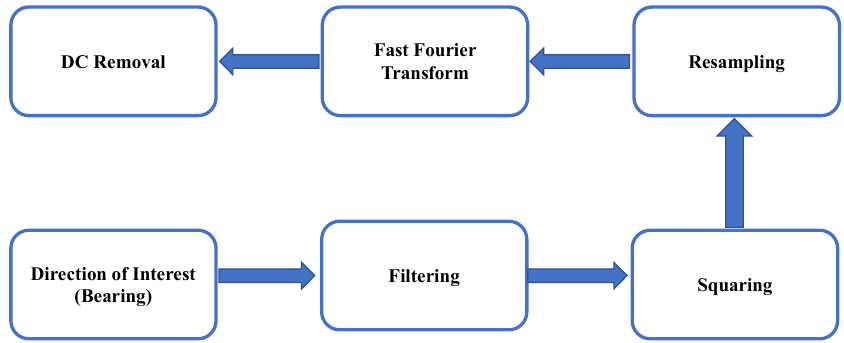
Figure 3. Block diagram of DEMON processing [6].